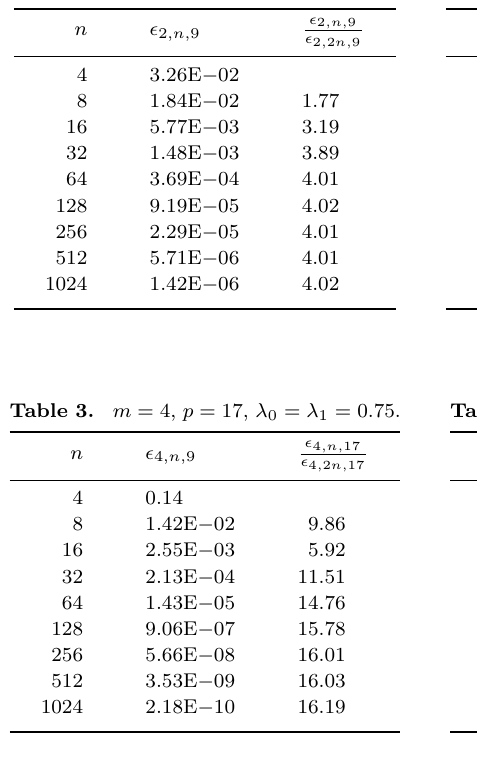
Table 1. m = 2, p = 9, λ 0 = λ 1 = 0 . 75. Table 2. m = 3, p = 12, λ 0 = λ 1 = 0 . 75.